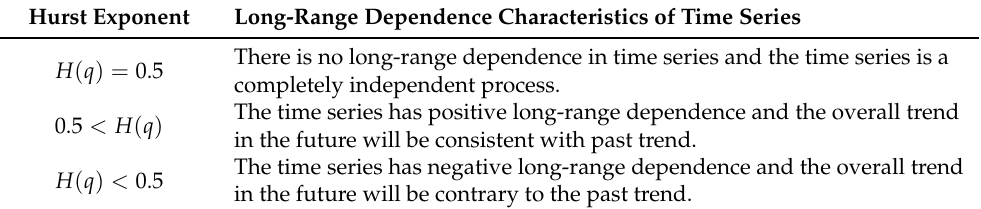
Table 1. The relationship between the long-range dependence of time series and the generalized Hurst